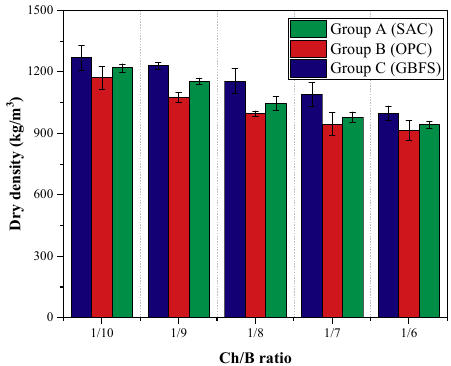
Figure 7. Dry density of the different groups.